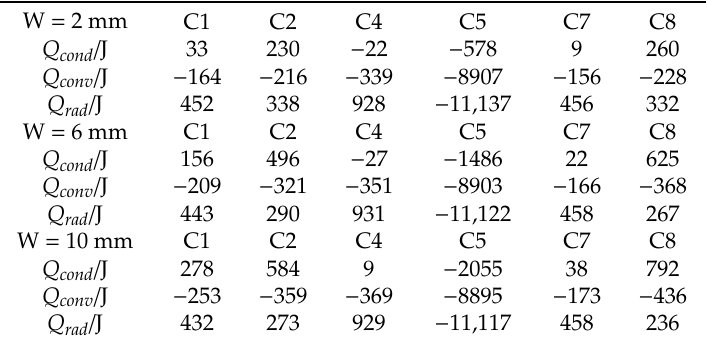
Table 4. Heat exchange quantities of each cell when W = 2, 6 and 10